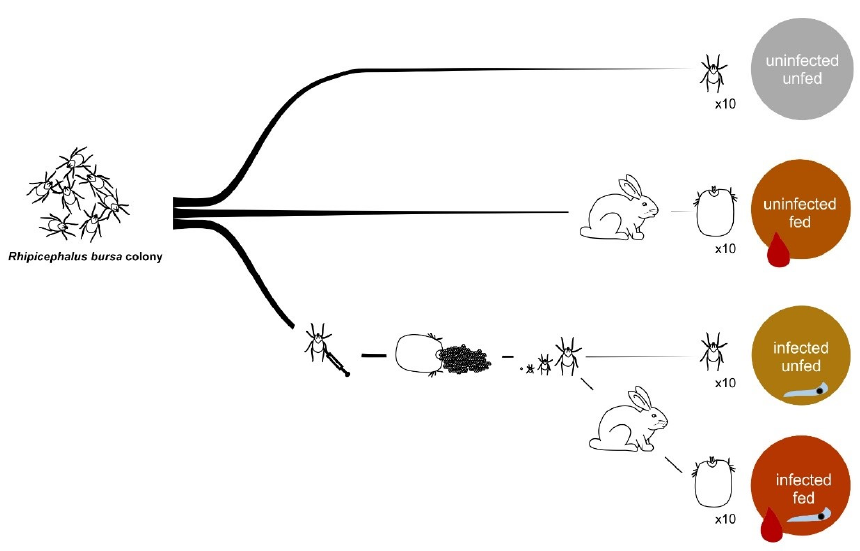
Figure 1. Experimental design for production of ticks at different feeding and infection conditions. From a pathogen-free colony, four groups of 10 R. bursa females were generated in triplicate: uninfected unfed (grey circle), uninfected fed (orange circle), infected unfed (yellow circle), and infected fed (red circle). The uninfected unfed ticks were obtained directly from the colony; and the uninfected fed ticks were carefully detached from the rabbit ear after blood meal. Infection of groups were achieved by inoculation of B. ovis in female ticks. After egg laying and hatching, infected batch of larvae developed to the adult phase. To obtain the infected unfed group, ticks were directly used, and to obtain infected fed groups, ticks were allowed to feed. Finally, tick salivary glands were dissected to perform the proteomics analysis of the R. bursa sialoproteome.